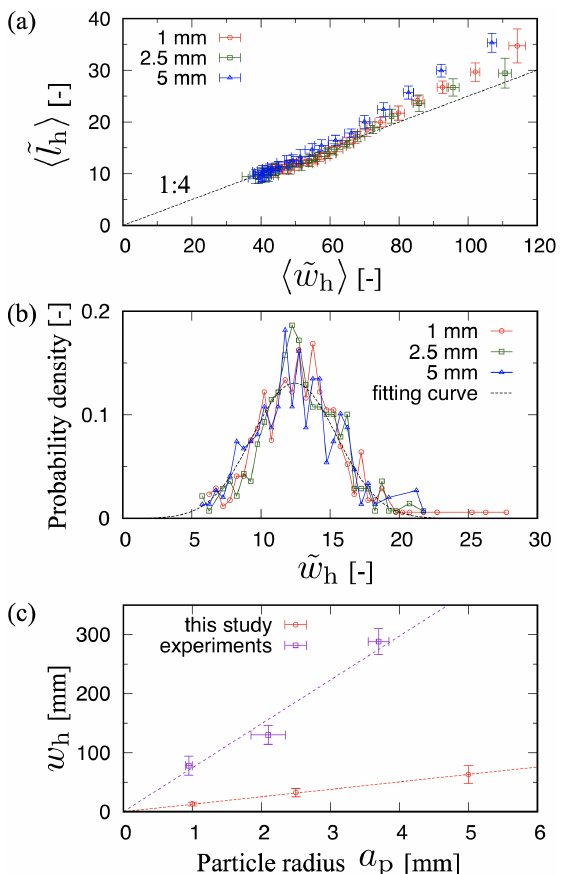
Figure 10. Variabilities in head size defined in Figure 8. Here, ˜ w h and ˜ l h are the width and layer thickness of the head normalized by the particle radius a p . ( a ) Relationship between ˜ w h and ˜ l h in the circular set-up. The mean and standard deviation of 20 simulations are denoted by a point and an error bar, respectively. The data are shown at a constant time interval depending on a p : ∆ t = 10 − 3 , 5 × 10 − 4 , and 2.5 × 10 − 4 s ( a p = 1, 2.5, and 5 mm). ( b ) Probability densities of ˜ w h in the rectangular setup. Each line is calculated from the final states of 20 simulations. The dashed black line is a Gaussian distribution fitting the data of a p = 5 mm. ( c ) Comparison of head width with previous experiments [23]. The mean and standard deviation of panel ( b ) are shown. The dashed lines are linear functions fitting the simulation and experimental